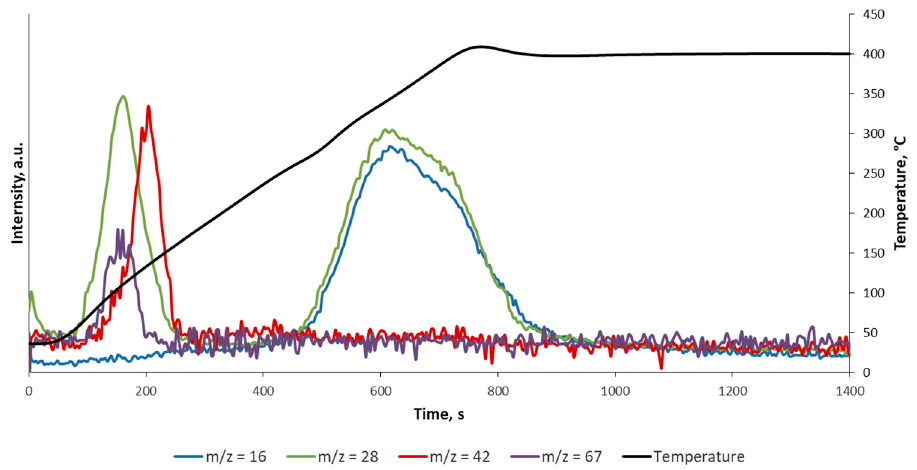
Figure 1. Decomposition of cymantrene on 0.068%Pd/Al 2 O 3 in H 2 flow at temperatures of 40–400 °C.